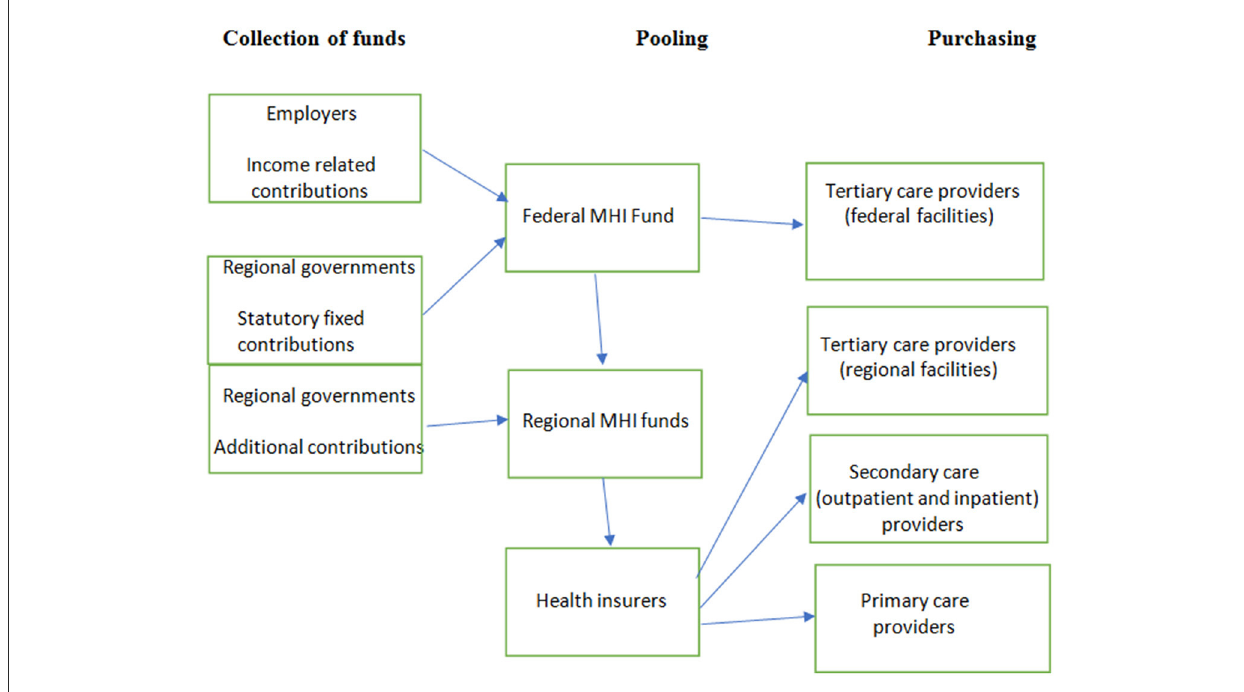
FIGURE1 Financial flows in the Russian MHI